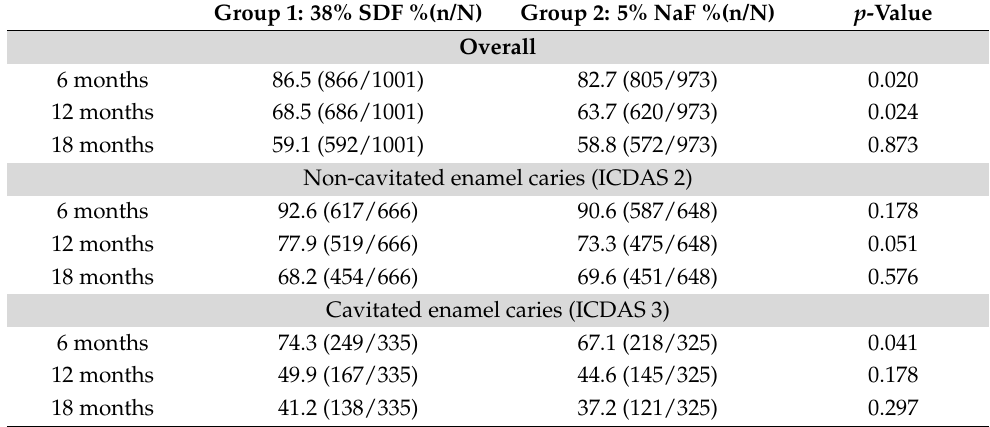
Table 2. Caries arrest rate of enamel carious tooth surfaces at 6, 12, and 18-month follow-up